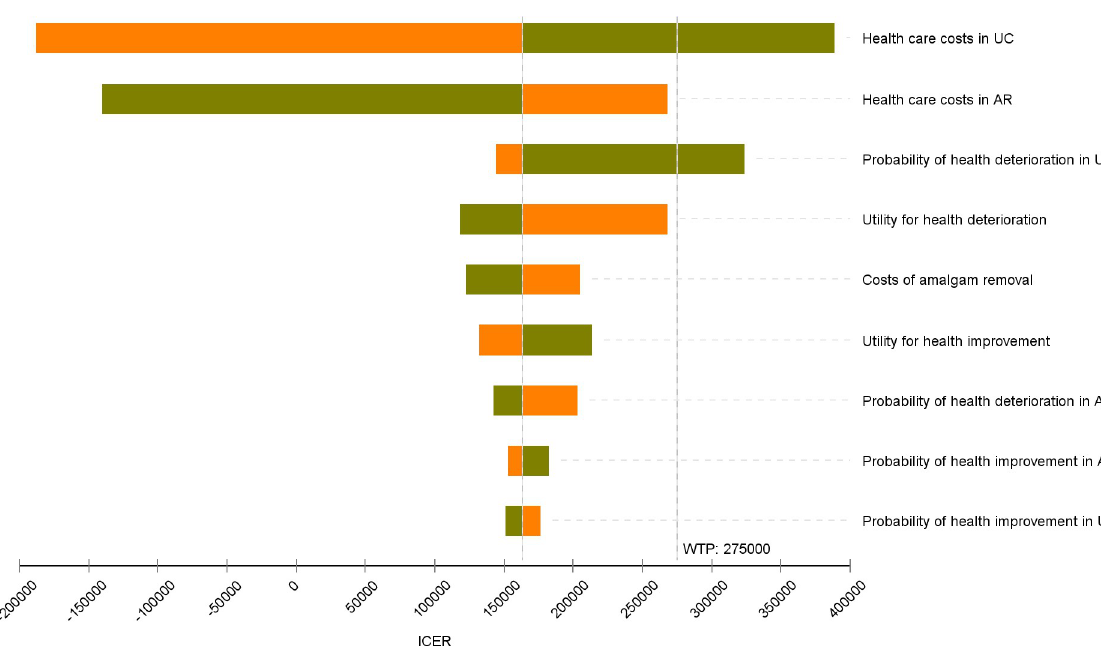
Fig 2. Tornado diagram illustrating results from one-way sensitivity analyses. UC : Usual care; AR : Amalgam removal; ICER : Incremental cost-effectiveness ratio.